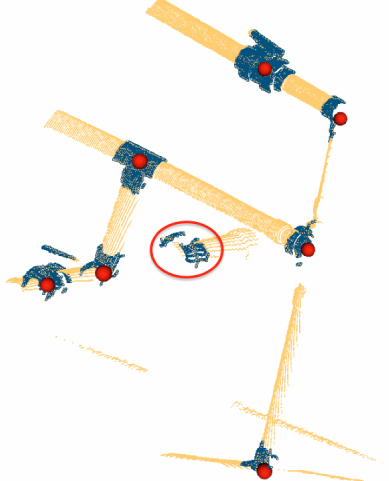
Figure 5. Semantic Segmentation: Red points represent the centroids of segmented objects. The red circle shows a segmented object located at an isolated extremity.